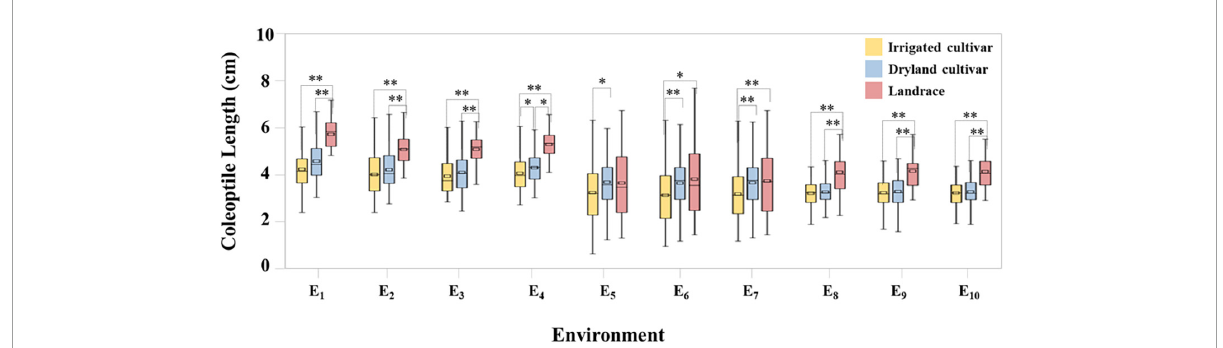
FIGURE1 Coleoptile length of irrigated cultivars, dryland cultivars, and landraces. ∗ and ∗∗ represent significance level of P < 0.05 and P < 0.01, respectively.